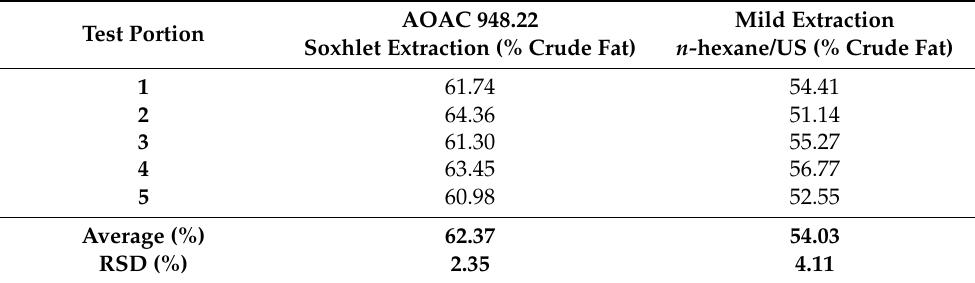
Table 2. Crude fat percentage results, with average and relative standard deviation.